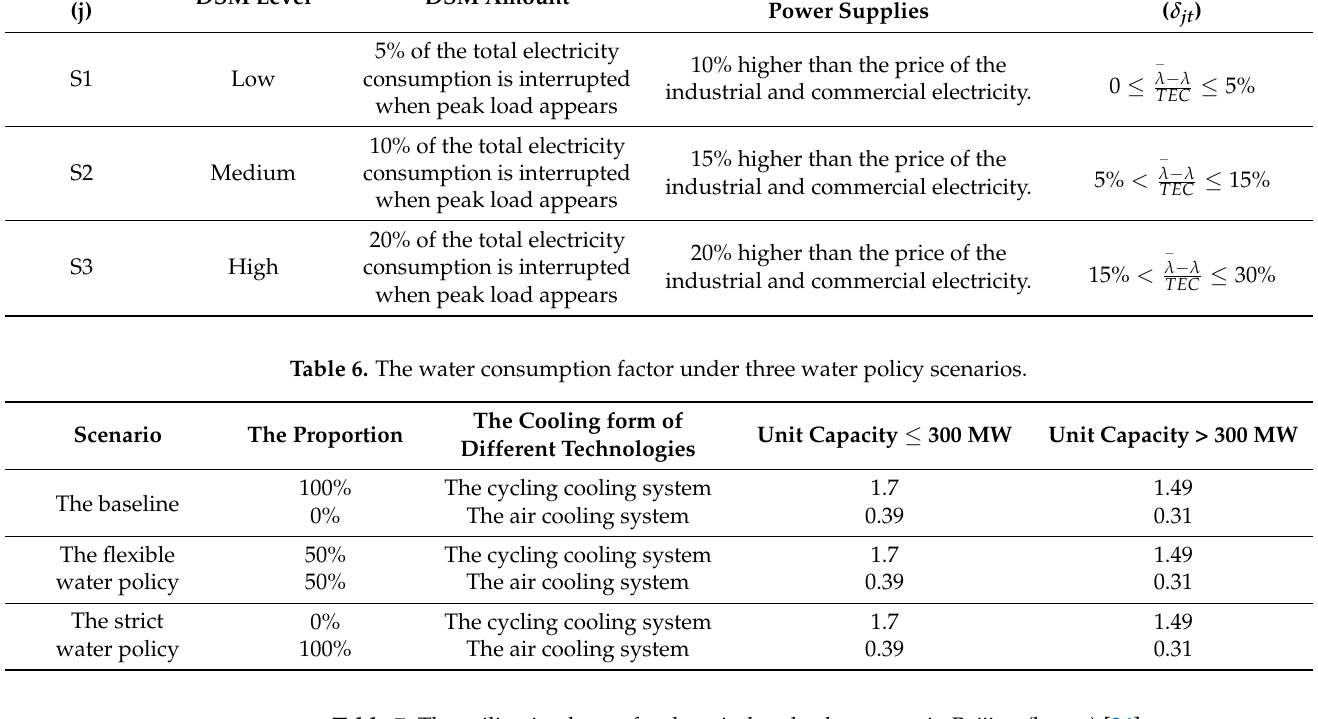
Table 7. The utilization hours for the wind and solar power in Beijing (hours)